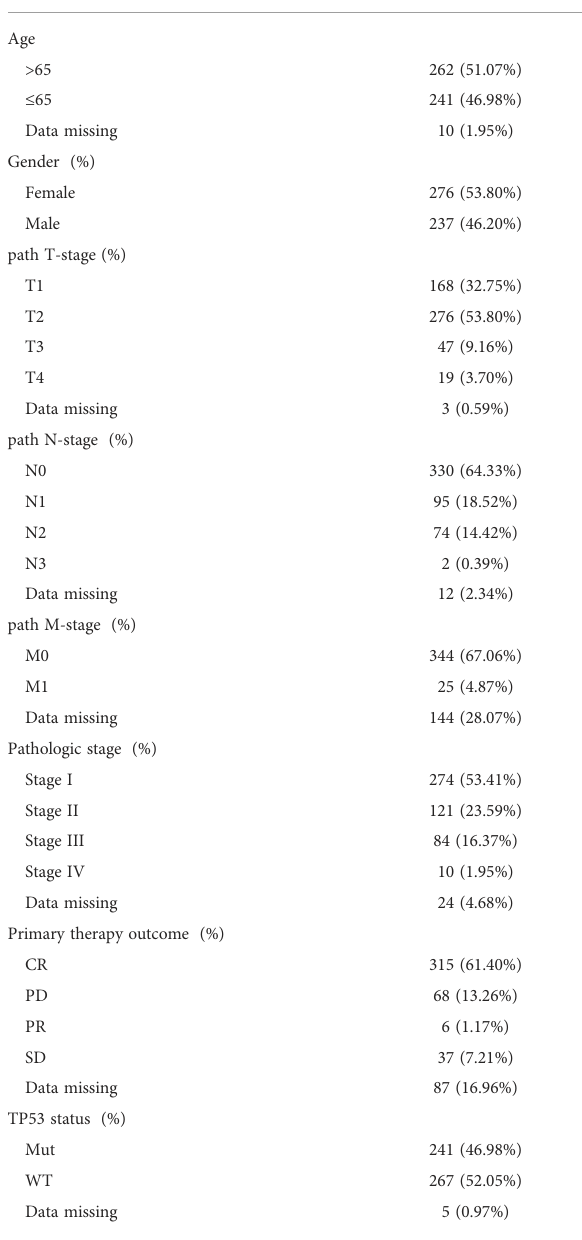
TABLE 1 The clinicopathological characteristics of LUAD in patients with TCGA.